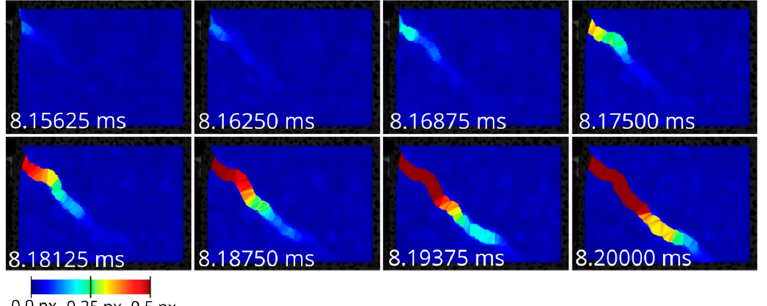
(cid:12) (cid:12)(cid:12) (cid:12) (cid:12)(cid:12) → (cid:12) (cid:12) (cid:12) (cid:12) (cid:12) (cid:12) (cid:12) (cid:12) t rel (cid:12) (cid:12) of a sequence of one of the experiments at the 160 kHz imaging